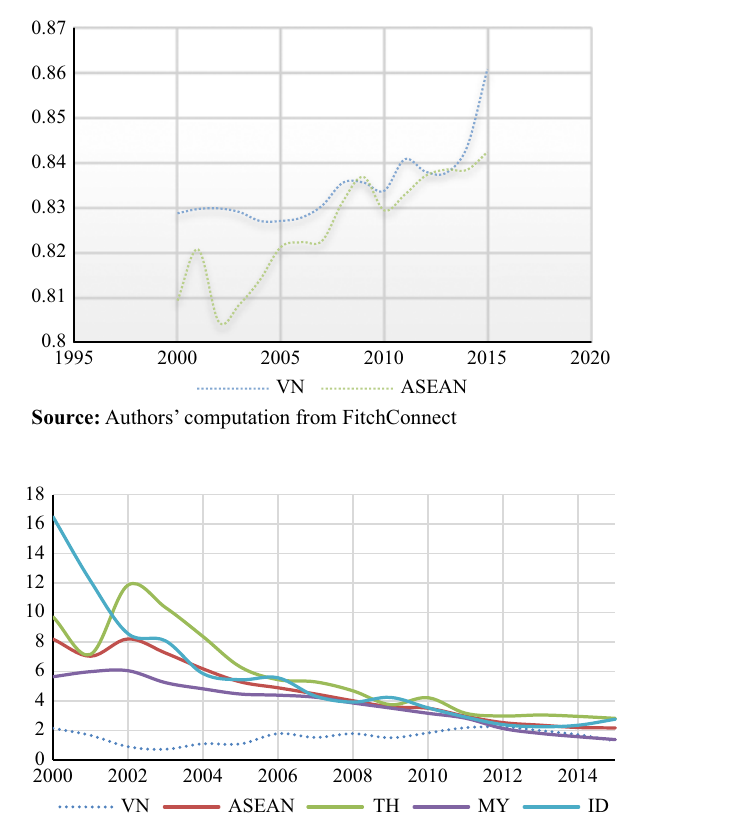
Figure 7. Loan loss reserves (as % of total gross loan)